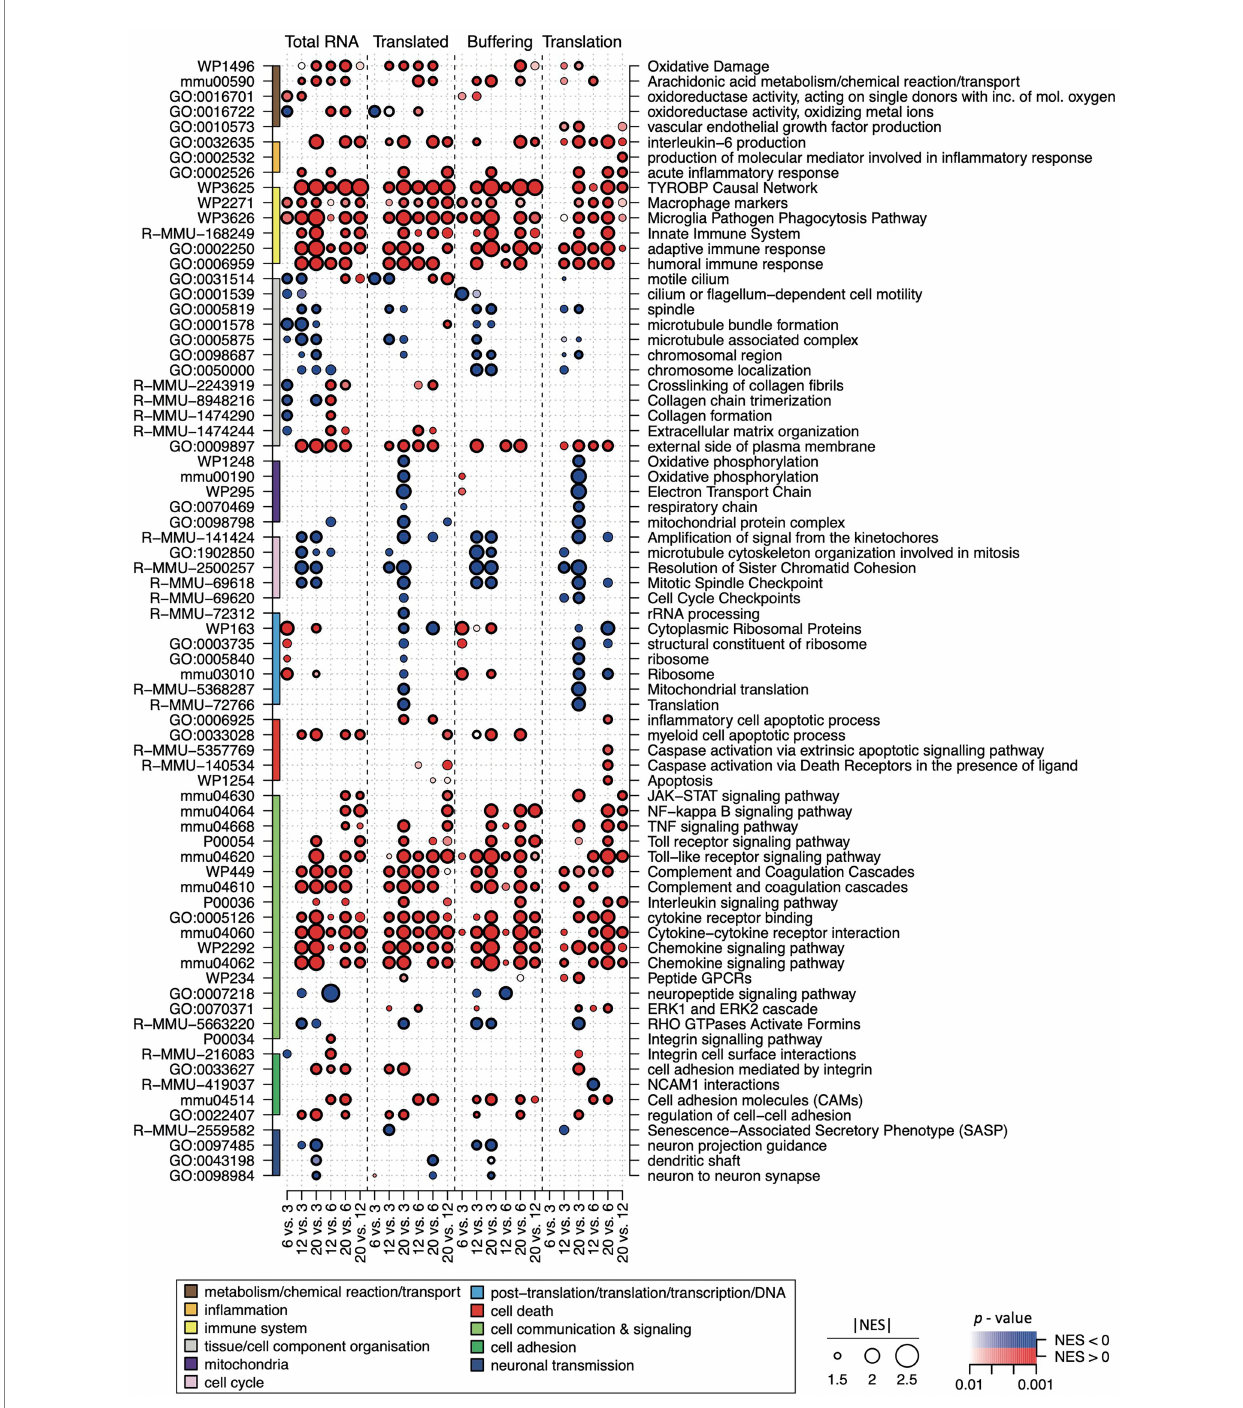
FIGURE 4 GSEA of the transcriptome (“Total RNA”), translatome (“Translated”) and the “Buffering” and “Translation” regulatory modes defined with anota2seq. 74 significantly enriched terms (left: ID numbers) across time comparisons (bottom horizontal axis) are shown. Normalized enrichment scores (|NES|) for each term are displayed and are proportional to the circle size. The colormap refers to p -values indicated at the bottom, circles with a black border line refer to terms with FDR < 0.05. Red: terms associated with up-regulated genes (+ NES score); blue: terms associated with down-regulated genes ( − NES score). 74 terms were manually allocated to 11 functional classes (colors in left vertical axis) and described in the bottom right